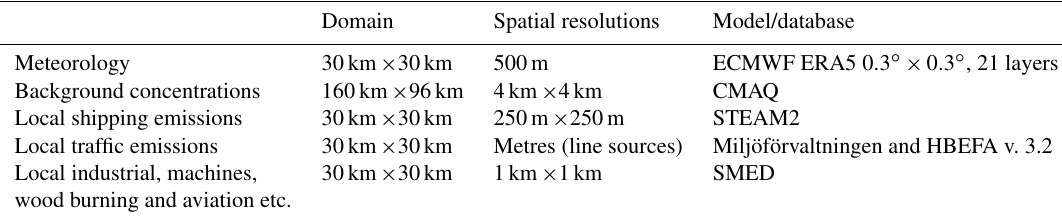
Table 1. City-scale model